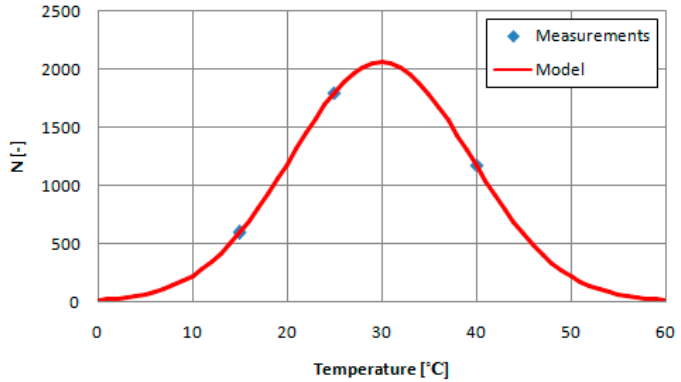
Figure 1. Impact of ambient temperature on cell cycle number. 175